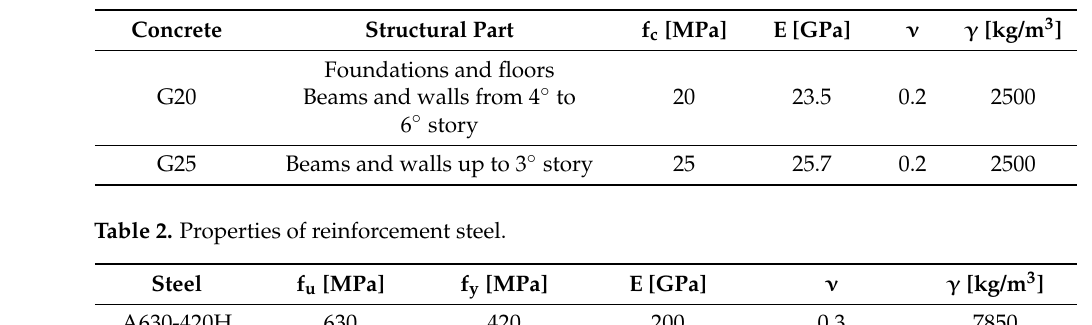
Figure 4. Typical details of the reinforcement of some structural members. Table 1. Properties of concrete.